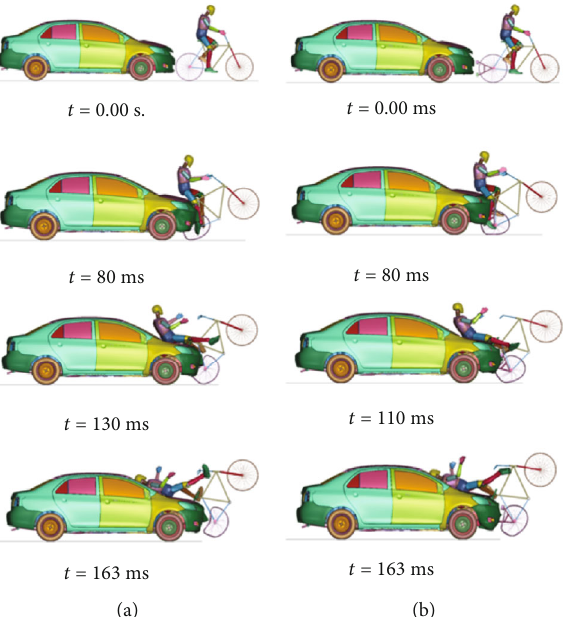
Figure 9: Cyclist overtaking impact at 50km/h without a passive safety system (left) and with a passive safety system (right).